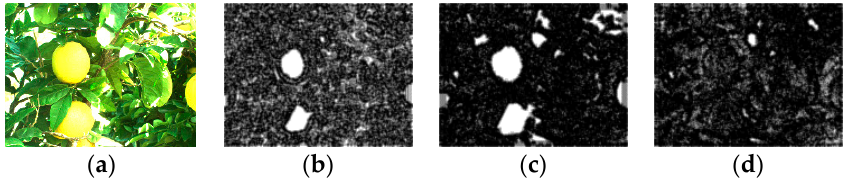
Figure 6. Entropy filter of RGB citrus fruit color image, ( a ) VIS color image; ( b ) Entropy filter of R component in level 3 of DWT; ( c ) Entropy filter of G component in level 3 of DWT; ( d ) Entropy filter of B component in level 3 of DWT.